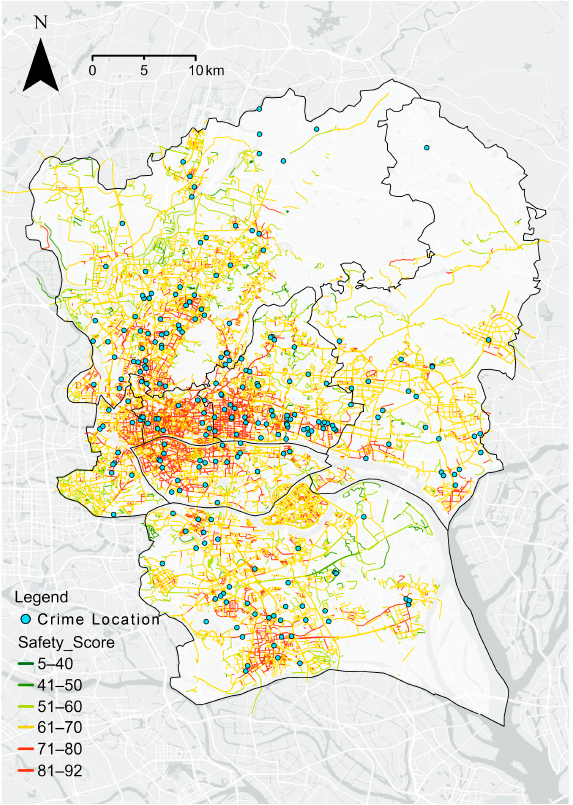
Figure 8. Women’s perceived safety score map. Map data sources: (c) OpenStreetMap contribu- tors.